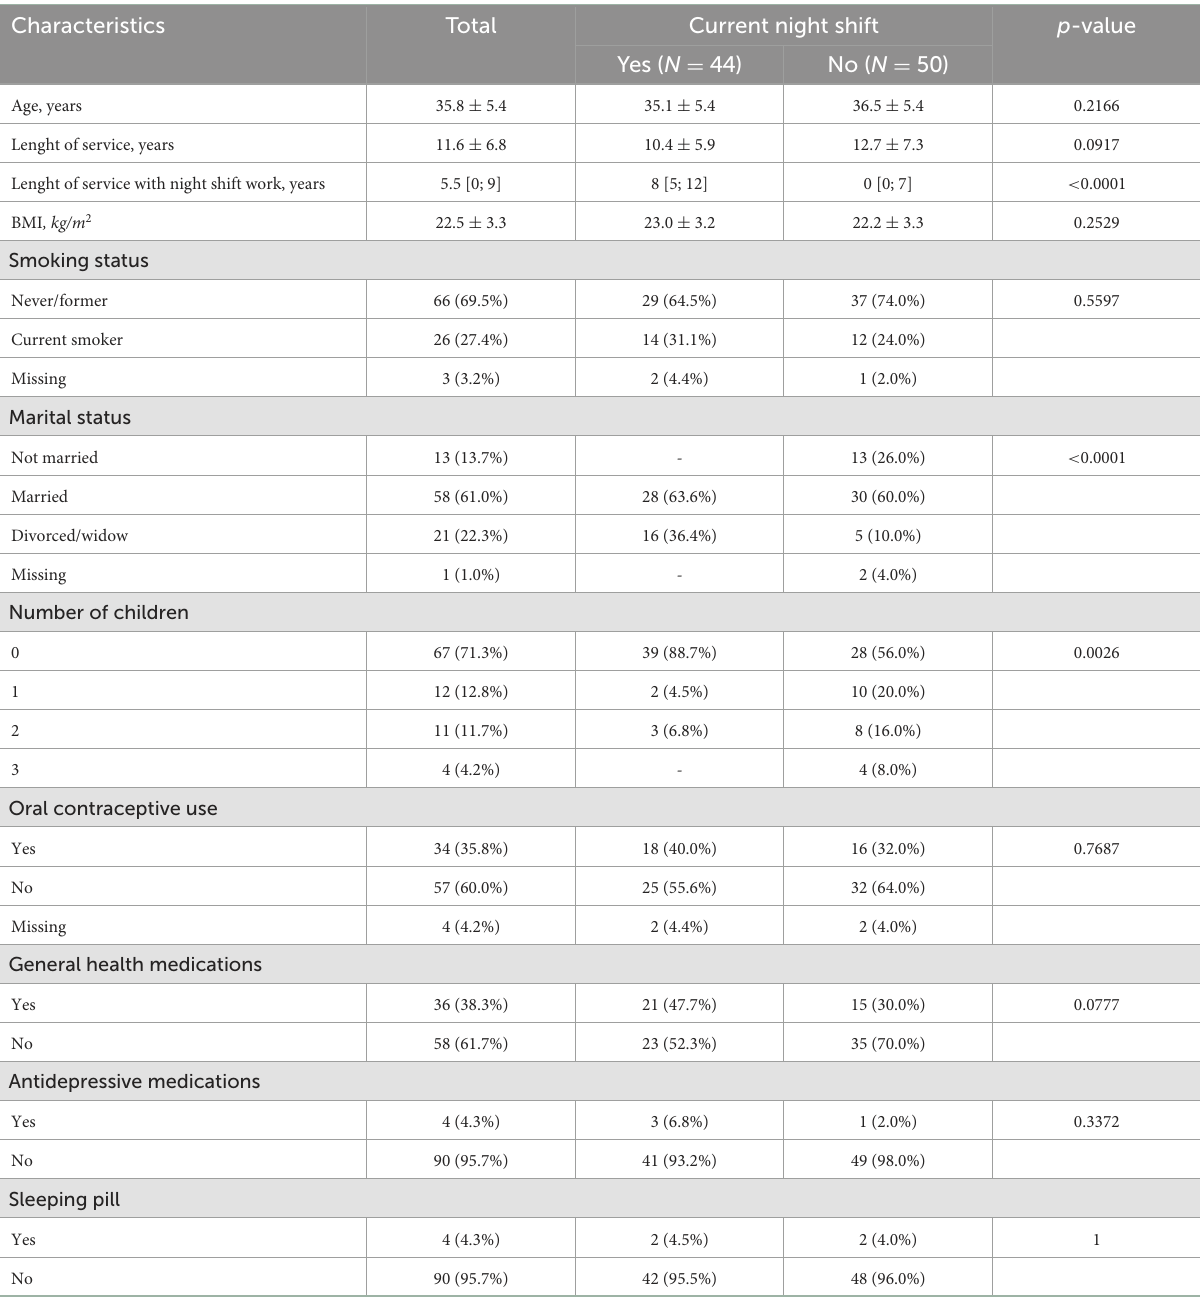
TABLE 1 Characteristics of the study participants.